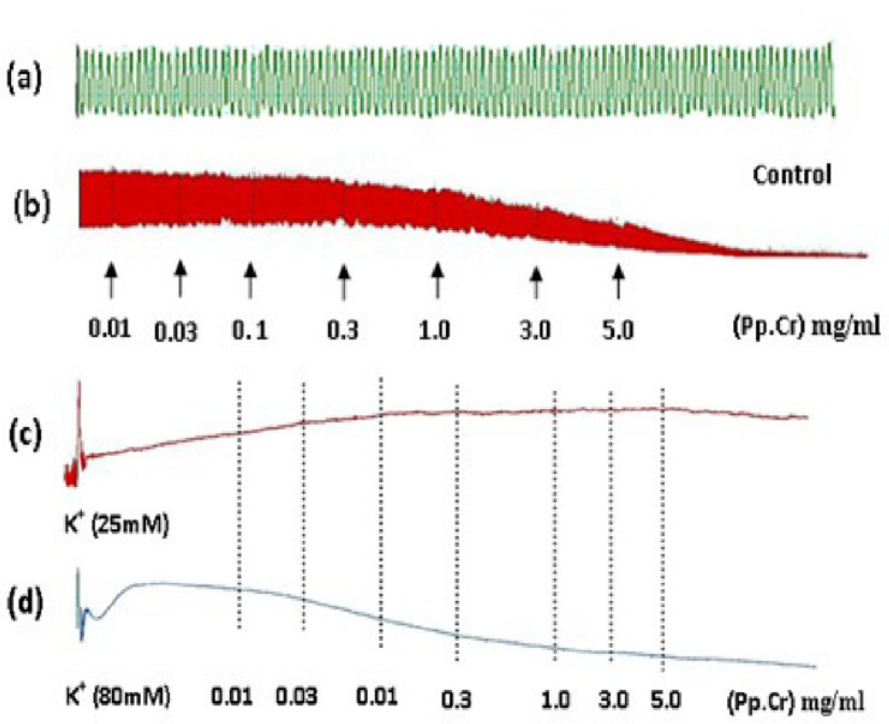
Fig 1. Original tracings presenting (a) spontaneous contraction of isolated rabbit jejunum in controlled biological environment and spasmolytic effect mediated by crude ethanolic extract of Pyrus pashia (Pp.Cr) on (b) spontaneous (c) low K + (25 mM) and (d) high K + (80 mM) induced tissue contraction. Pp.Cr was added in increasing concentrations and values listed were the final tissue bath concentrations. Each tracing is a presentation of single jejunum